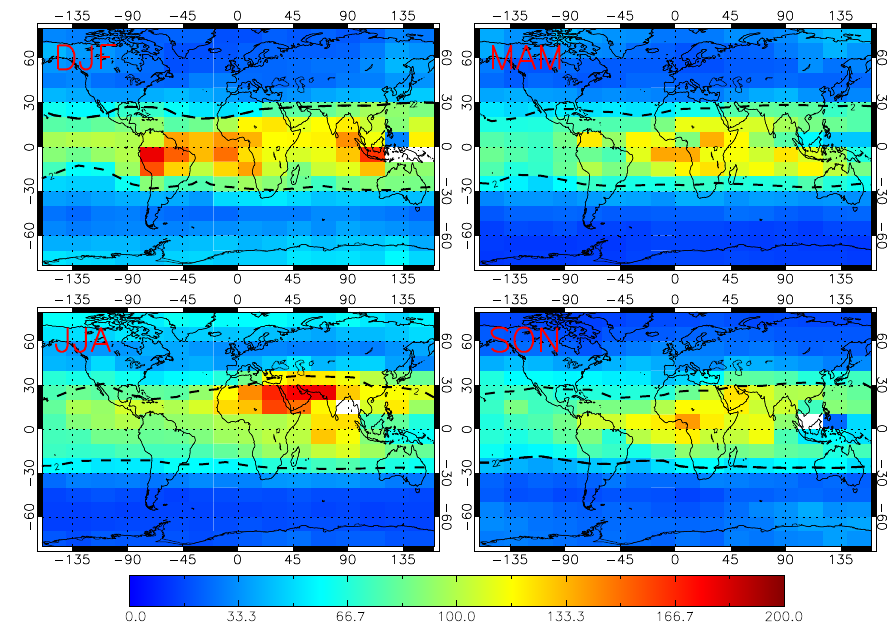
Figure 11. As Fig. 10 but for the application of the UoL averaging kernels to the TOMCAT model